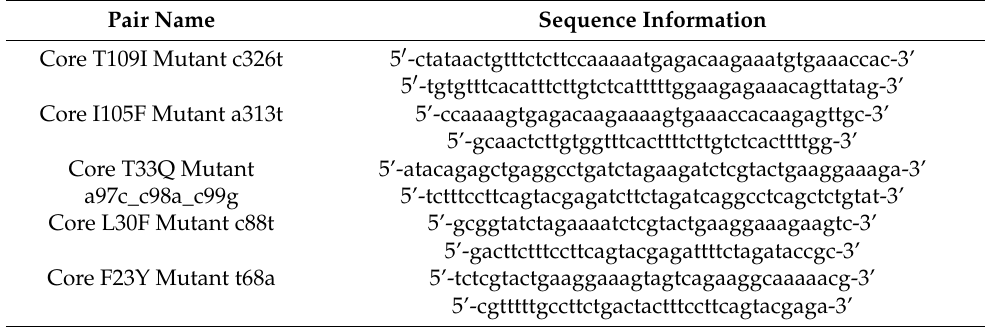
Table 5. Primers used for site-directed PCR mutagenesis of HBV